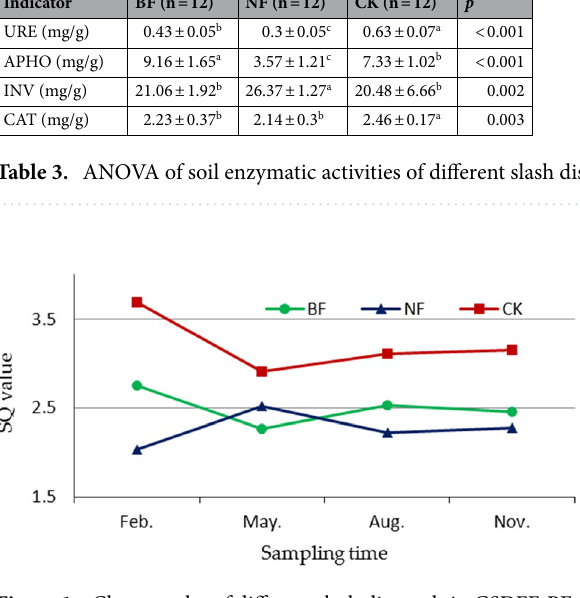
Figure 1. Change rules of different slash disposals in GSDFF. BF means burning forest, NF means no-burning forest, CK means